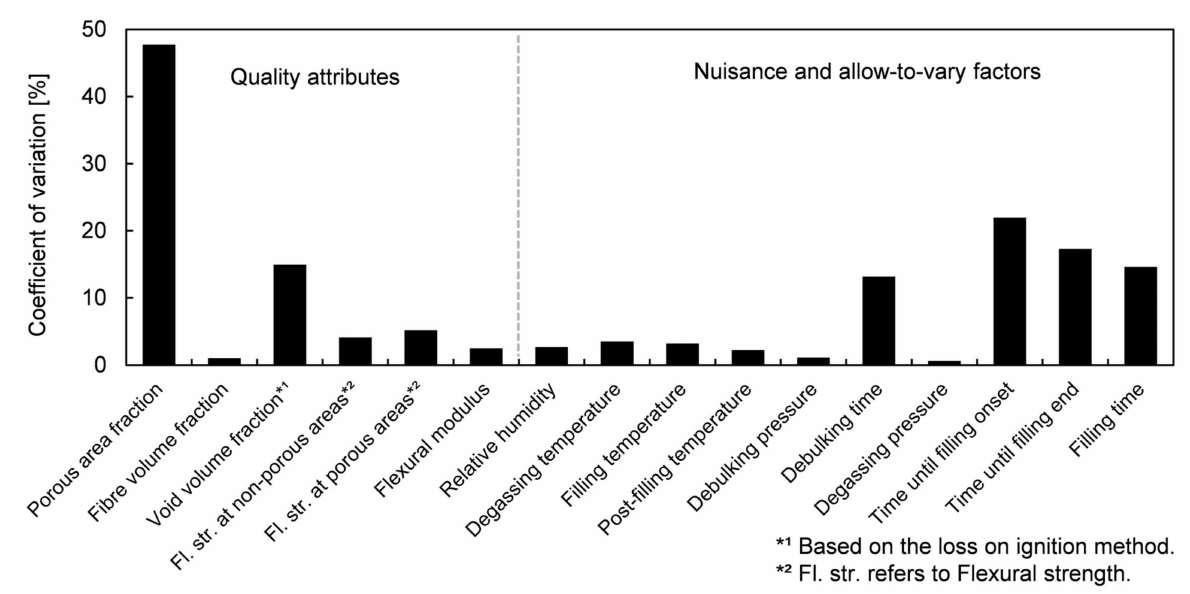
Figure 12. Coefficients of variation of measured quality attributes and monitored nuisance and allow-to-vary